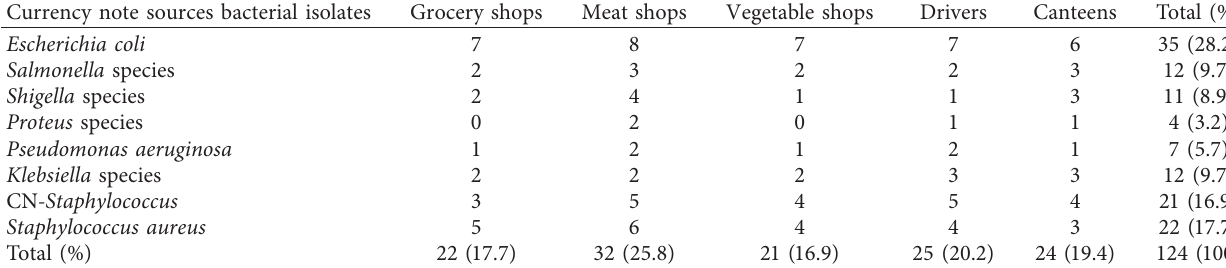
Table 2: Distribution of bacterial isolates according to sources of currency notes.